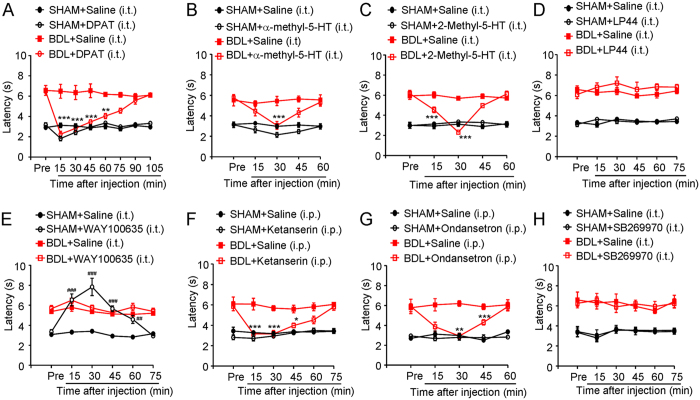
The effects of 5-HT receptors agonists or antagonists on antinociception in sham and BDL rats.(A) I.t. injection of 5-HT1A receptor agonist DPAT decreased the latency of tail-flick response to 52 °C hot water in BDL rats, but not sham rats (n = 6–8 per group). (B) I.t. injection of 5-HT2 receptor agonist α-methyl-5-HT decreased the latency of tail-flick response to 52 °C hot water in sham and BDL rats (n = 6–8 per group). (C) I.t. injection of 5-HT3 receptor agonist 2-Methyl-5-HT decreased the latency of tail-flick response to 52 °C hot water in BDL rats, but not sham rats (n = 6–8 per group). (D) I.t. injection of 5-HT7 receptor agonist LP44 failed to change the latency of tail-flick response to 52 °C hot water in sham and BDL rats (n = 6–8 per group). (E) I.t. injection of 5-HT1A receptor antagonist WAY-100635 significantly increased the latency of tail-flick in response to 52 °C hot water in sham and BDL rats (n = 6–8 per group). (F) I.p. application of 5-HT2 receptor antagonist ketanserin significantly reduced the latency of tail-flick in response to 52 °C hot water in BDL rats, but not sham rats (n = 6–8 per group). (G) I.p. application of 5-HT3A receptor antagonist ondansetron significantly reduced the latency of tail-flick in response to 52 °C hot water in BDL rats, but not sham rats (n = 6–8 per group). (H) I.t. injection of 5-HT7 receptor antagonist SB269970 failed to change the latency of tail-flick in response to 52 °C hot water in sham and BDL rats (n = 6–8 per group) (*P < 0.05; **P < 0.01, ***P < 0.001 vs. saline values from sham rats; ##P < 0.01, ###P < 0.001 vs. saline values from BDL rats and analyzed by two-way AVOVA following Bonferroni post hoc test).